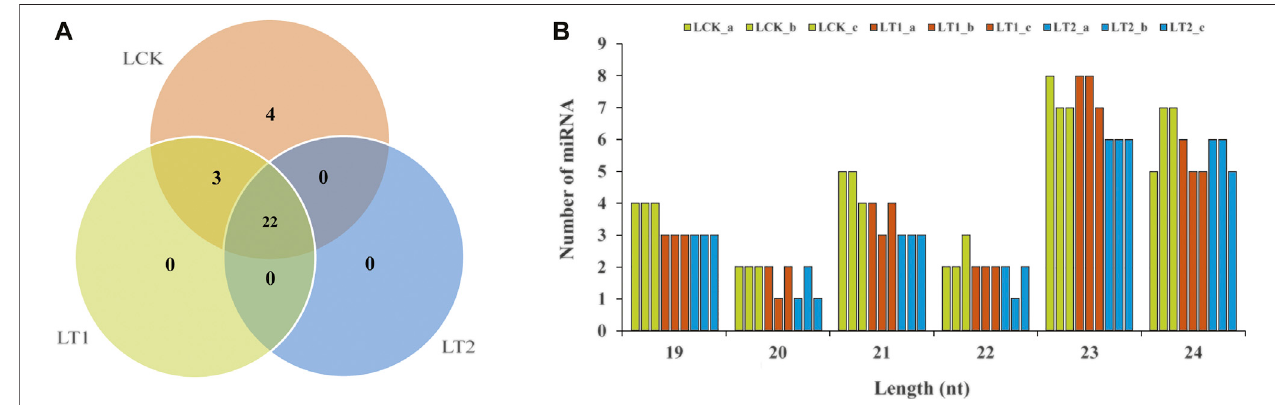
FIGURE3| Novel miRNAs identi fi edin S.apetala byhigh-throughput sequencing. (A) Distribution ofnovel miRNAs in control(LCK), 1 day (LT1)and 28 days (LT2) salinity treatment. (B) The length distribution of S. apetala novel miRNAs. a, b and c represent the three biological repetitions for each